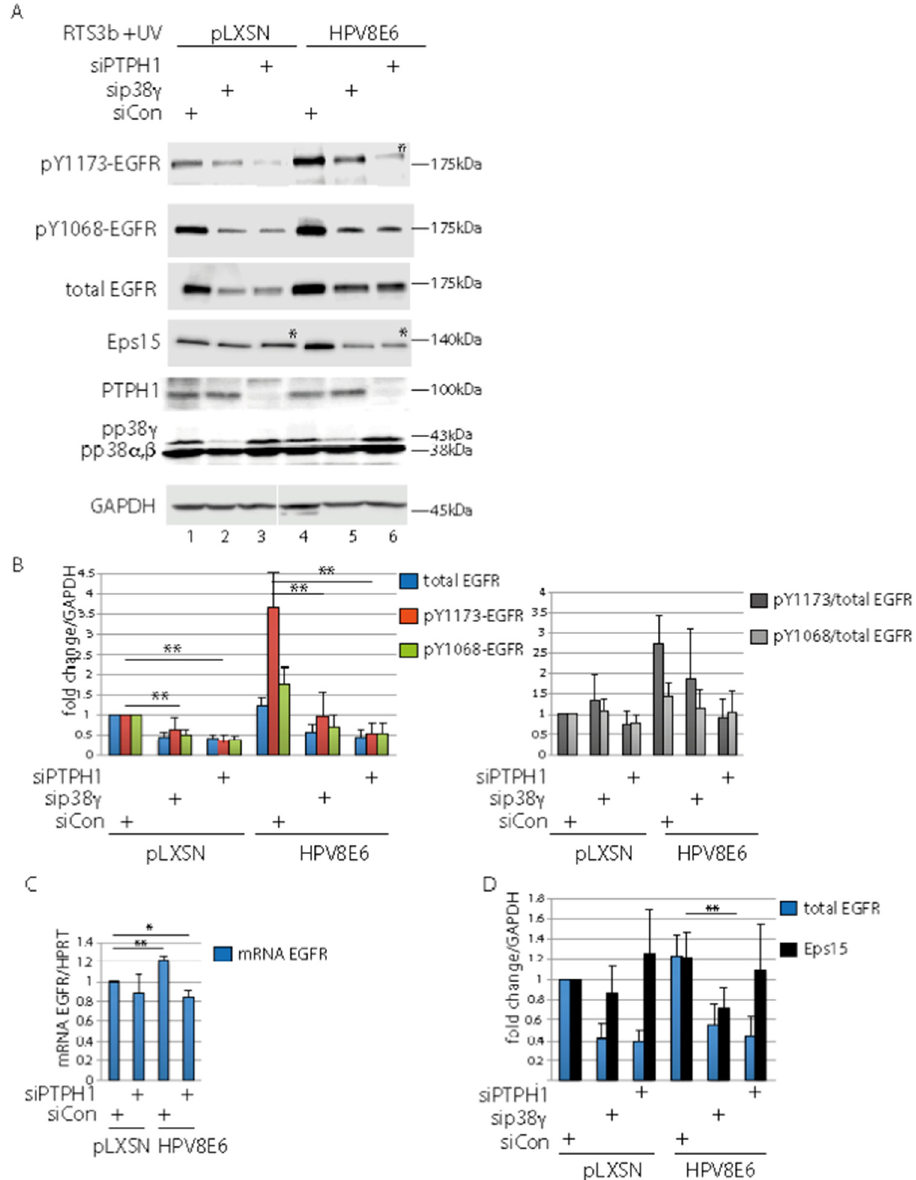
Figure 5. PTPH1 affects the EGFR in UV-exposed keratinocytes. ( A ) RTS3b-8E6 and control cells were transfected with siRNA against PTPH1, p38 γ or control. 24 h later the cells were incubated in serum free medium for 16 h, irradiated with UV light, followed by further 30 min incubation. Total cell extracts were used in Western blot to detect the presence of the proteins as indicated in the figure. Note the higher migration of Eps15 and the pY1173-EGFR in Lanes 3 and 6, were PTPH1 was suppressed (indicated by *). ( B , D ). The blots were developed with the use of IRDye conjugated secondary antibodies (Li-Cor) and the signals were quantitated by the Image Studio software from Li-Cor. The signals obtained for EGFR versions and Eps15 were normalized to those for GAPDH and the fold differences were calculated. The relative amount of each factor in RTS3b-pLXSN-empty vector cells, transfected with control siRNA was set as 1. The graph shows the relative values for EGFR, pY1173-EGFR, pY1068-EGFR and the ratio pEGFR/EGFR from three and of Eps15 from six independent blots. ( C ) RT-PCR to determine the expression of the EGFR (n = 4) (** p < 0.01, * p < 0.05). The standard deviations are provided.